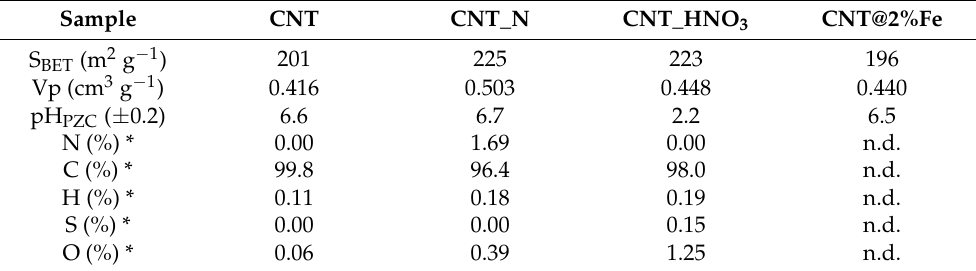
Table 1. Surface, textural, and elemental analysis of the different carbon nanotubes (CNT).